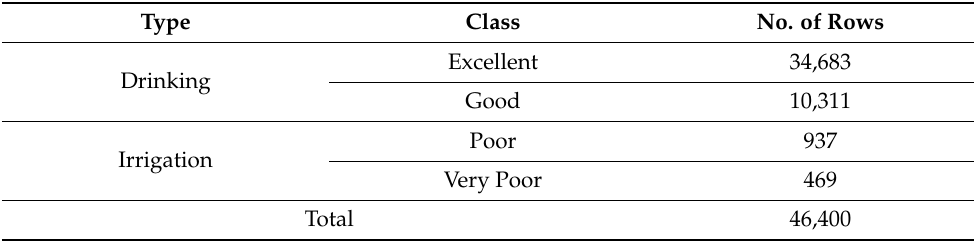
Table 2. The statistics of the GEOTHERM test dataset. Type Class No. of